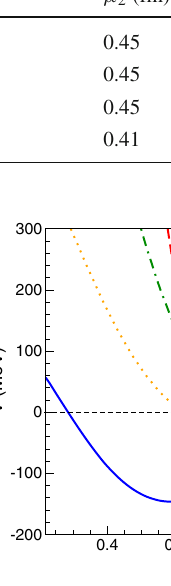
Table 2 The (cid:2)(cid:2) potential parameters used in the two-range Gaussian parametrization in Eq. (10) and the corresponding scattering parameters a 0 (fm) and r ef f (fm). The values are taken from [28] Model